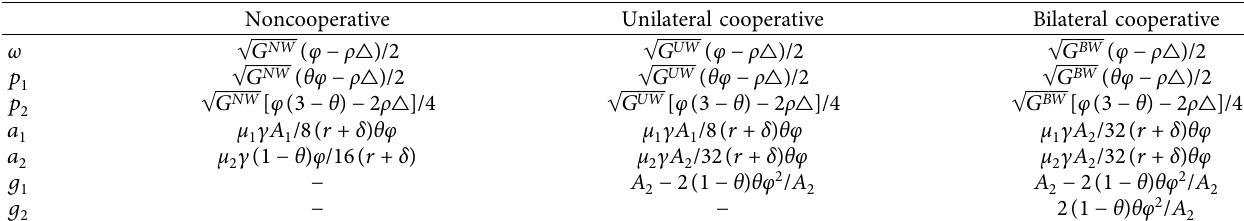
Table 5: The optimal solutions under a wholesale price